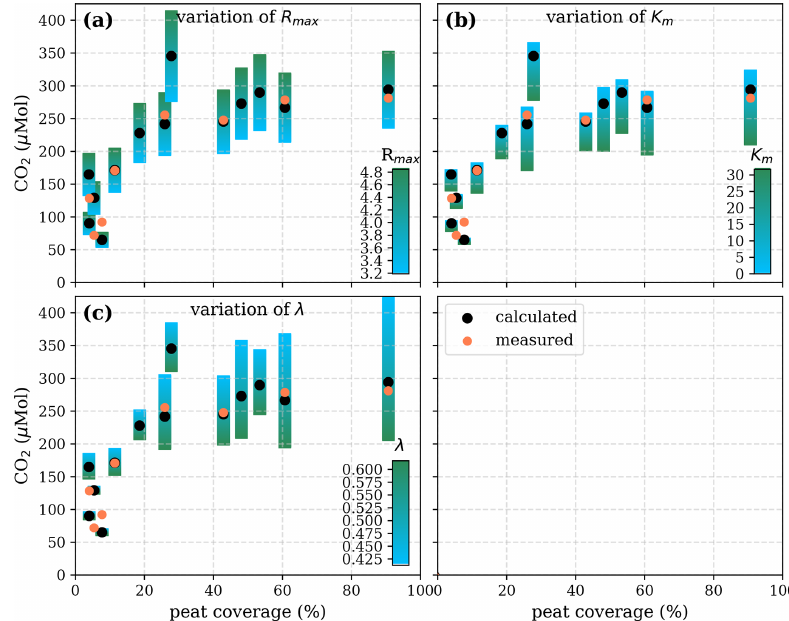
Figure A5. Sensitivity of calculated CO 2 to (a) the maximum decomposition rate ( R max ), (b) the Michaelis constant for O 2 concentration ( K m ), and (c) the exponential pH limitation constant ( λ ) according to the equation in Table 2 for the exponential pH approach and the parameter ranges given in Table 5.